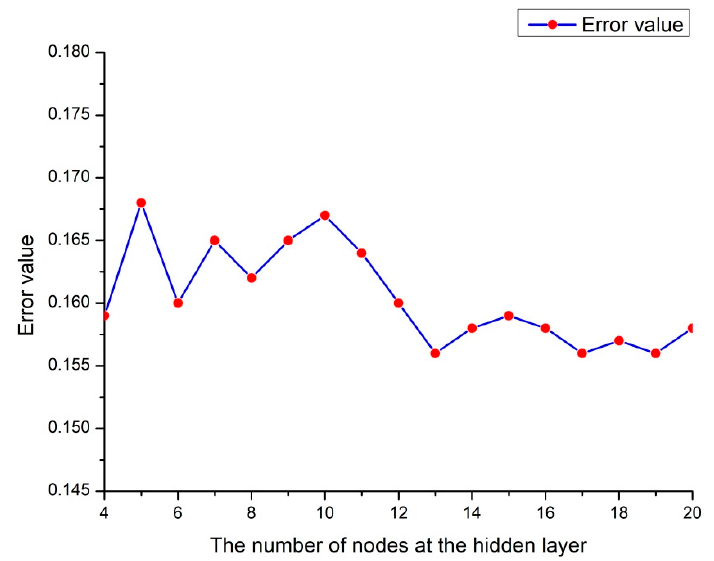
Figure 6. Relationship between prediction error rate and number of hidden layer nodes.